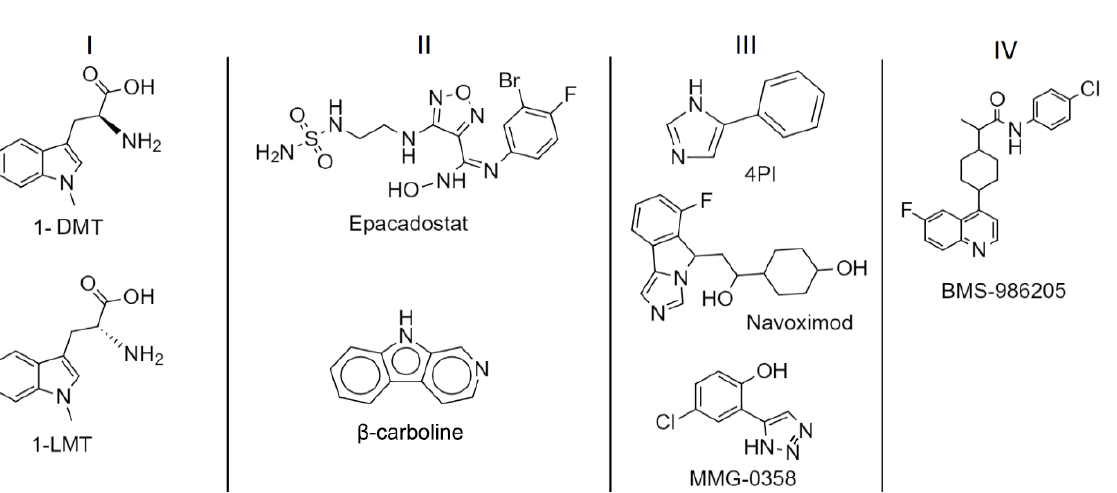
Figure 3. IDO1 inhibitors.